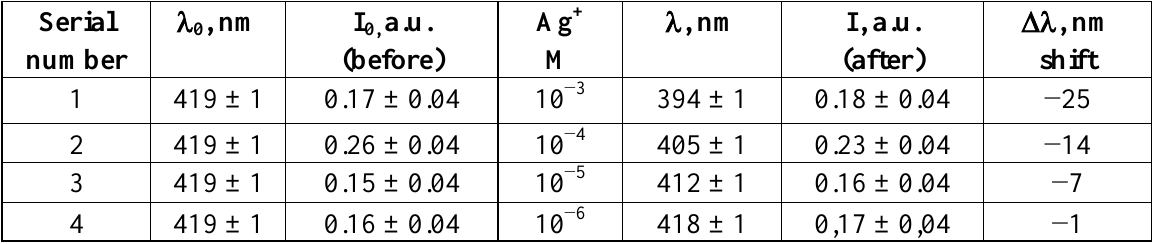
for the polymer-dye film based on PVC before (  AgClO 4